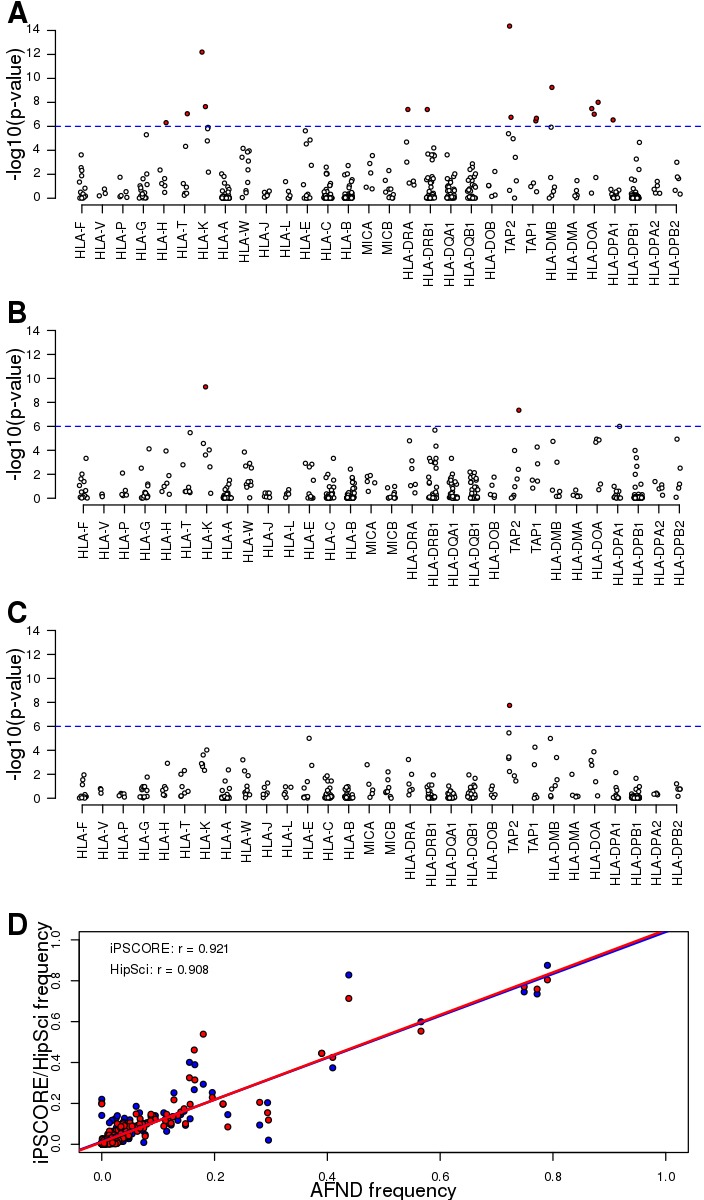
Allele frequencies of predicted HLA types.(A–C) Scatterplots showing the Hardy Weinberg test p-value for each HLA allele across (A) all unrelated Caucasian individuals, (B) unrelated Caucasian iPSCORE individuals and (C) unrelated Caucasian HipSci individuals. Red dots represent significant deviations from HWE (Bonferroni-corrected p-values<0.1). (D) Correlation between HLA allele frequency at the 4-digit resolution (identified by collapsing 8-digit HLA types) between individuals in the Allele Frequency Net Database (AFND) and either iPSCORE (red) or HipSci (blue). Each dot represents the frequency for a given HLA allele for unrelated individuals.